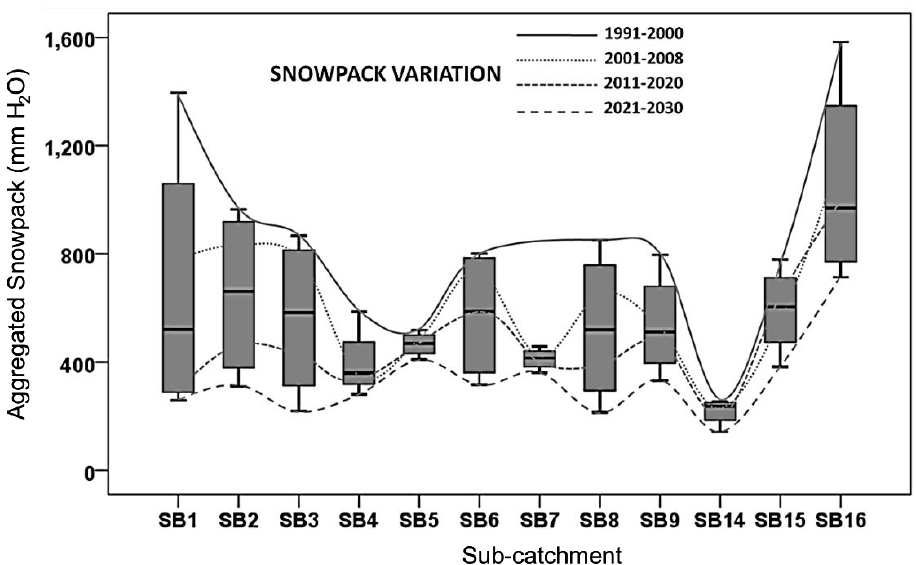
Figure 7. Changes in aggregated snowpack by decade (lines) at each sub-basin. The lines just evidence the difference of aggregated snowpack between decades (there is no physical process that connects sub-basins in the order observed in the x-axis).